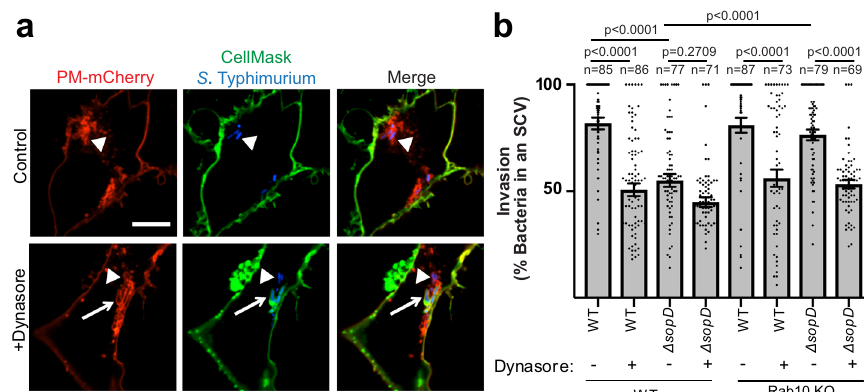
Fig. 6 SopD-mediated inhibition of Rab10 promotes plasma membrane scission during S . Typhimurium invasion via Dynamin-2. a Representative images of WT Henle 407 cells transfected with PM-mCherry and then infected with WT BFP- S . Typhimurium SL1344 for 20 min and labelled with CellMask (green), with or without Dynasore treatment. Arrow indicates a PM-mCherry positive Salmonella -containing compartment that is accessible to CellMask. Arrowhead indicates a sealed Salmonella -containing vacuole that is inaccessible to CellMask. Scale Bar, 10 μ m. Data are representative of three independent experiments. b WT or Rab10 KO Henle 407 cells were transfected with PM-mCherry 16 – 18 h prior to infection with WT or Δ sopD mutant S . Typhimurium with or without Dynasore treatment. Cells were then labelled with CellMask at 20 min post-infection and fi xed. Invasion is represented as the percent of bacteria in SCVs. The total number of bacteria that were positive for PM-mCherry at the invasion site was quanti fi ed and the proportion of these bacteria that were negative for CellMask was determined. These bacteria were in a sealed compartment that was considered an SCV and the number was used to represent the invasion ef fi ciency, at 20 min p.i. Data are means ± S.E.M. Statistical analysis was performed with one-way ANOVA. P -values and the number of independent cells used for measurements ( n ) are indicated in the fi gure. SCV Salmonella -containing vacuole, WT wild type, BFP blue fl uorescent protein, GFP green fl uorescent protein, KO knockout. Source data are included in source data fi